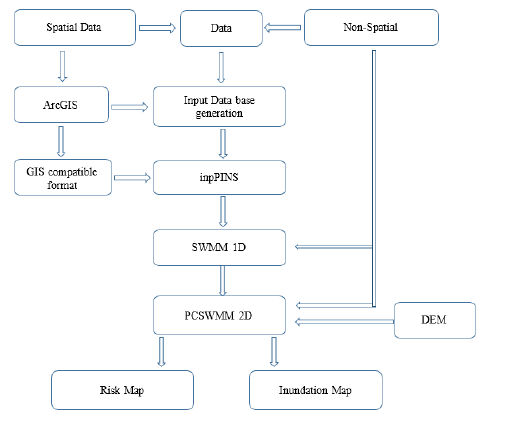
Figure 3: Flow chart of 1D-2D model development (Zone